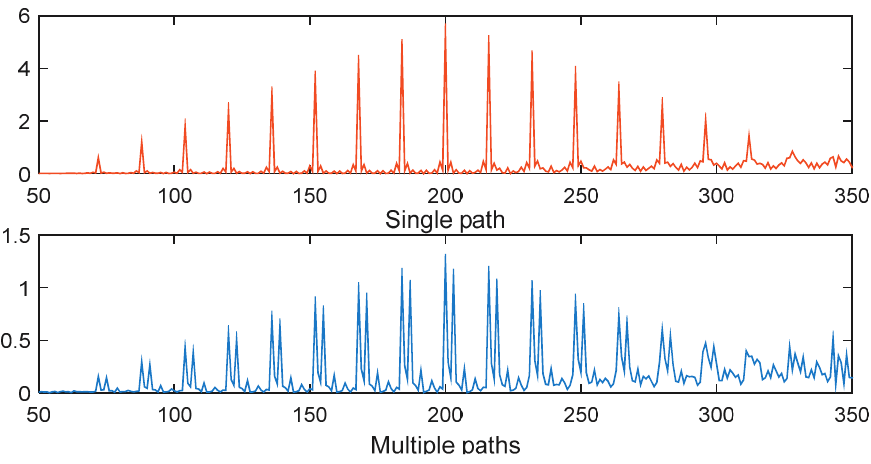
Figure 17 . The effect of multipath channel on the timing metric of the CSS